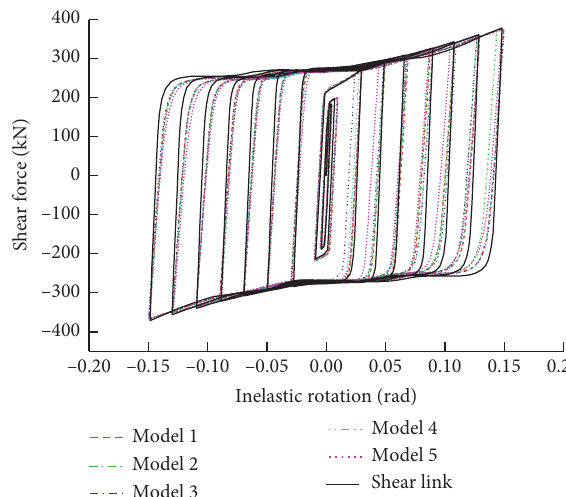
Figure 15: Hysteresis curves of